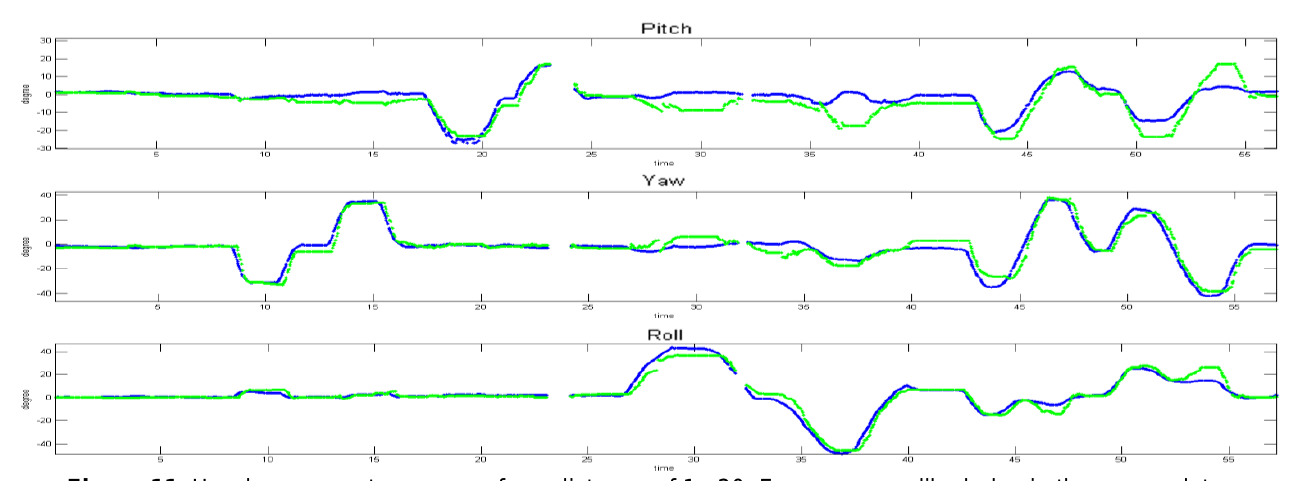
Figure 11. Head movement sequence for a distance of 1m20. Errors appear like holes in the green plots. Reference is in blue and KinectSDK is green.